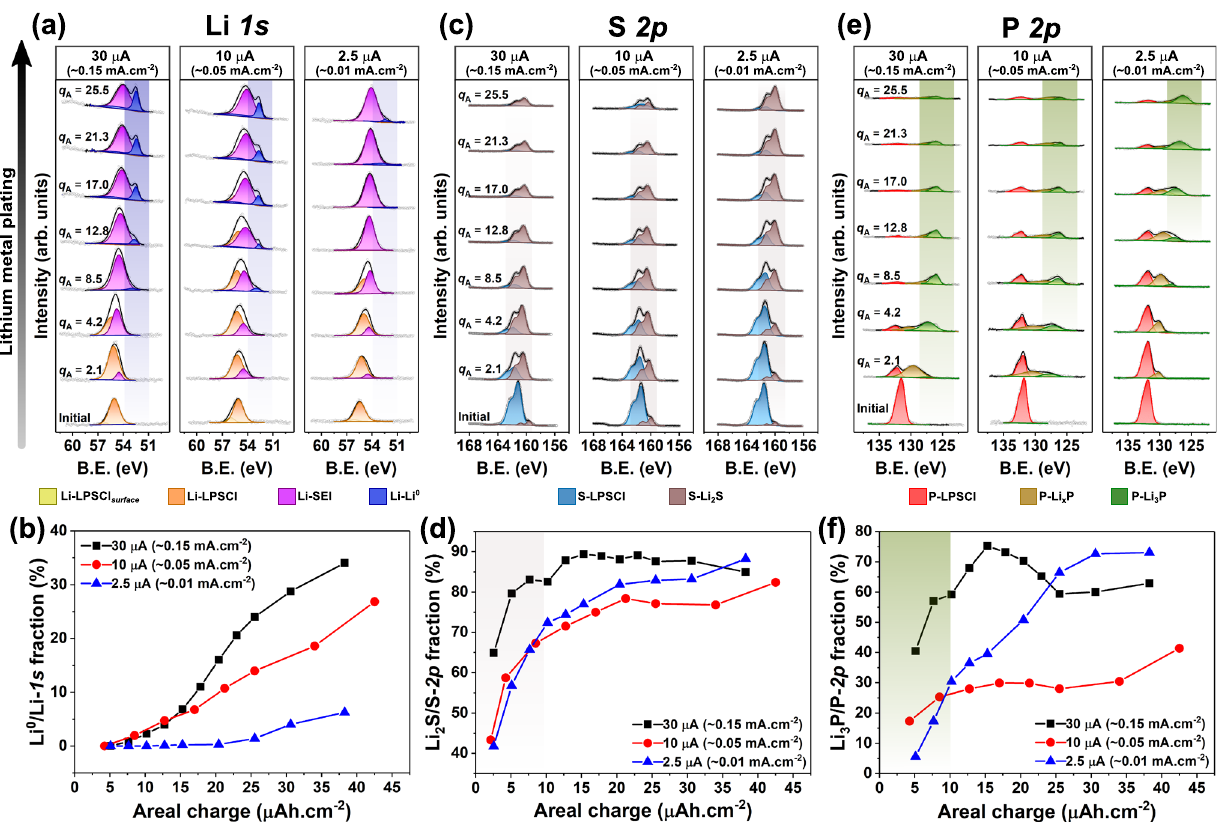
Fig. 2 | XPS measurements to study SEI evolution during virtual electrode plating at SE surface. Evolution of core-level XPS spectra during the virtual electrode plating process at the LPSCl surface, at applied EBCs of 30 μ A (or ~0.15mAcm − 2 , left panel), 10 μ A (or~0.05mAcm − 2 , central panel) and 2.5 μ A (or~0.01mAcm − 2 , right panel), for a Li 1s , c S 2p and e P 2p transitions, as a function of the charge passed, q A ( μ Ahcm − 2 ). Quanti fi cation of XPS spectra